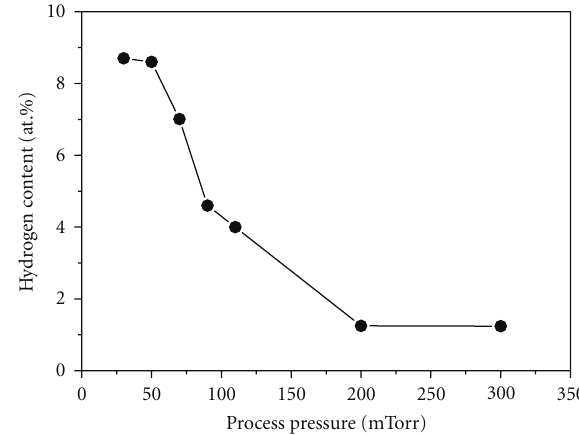
Figure 8: Variation of hydrogen content in Si:H films deposited by hot wire method as a function of process pressure.